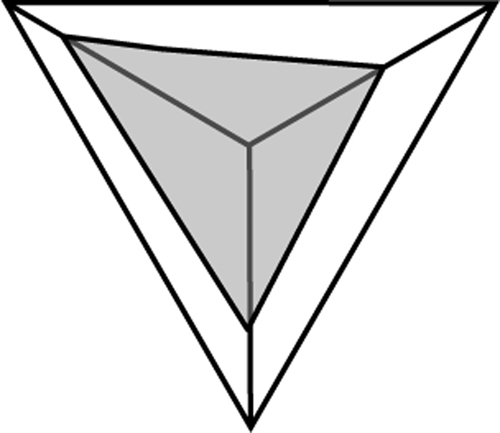
Non-creative user.